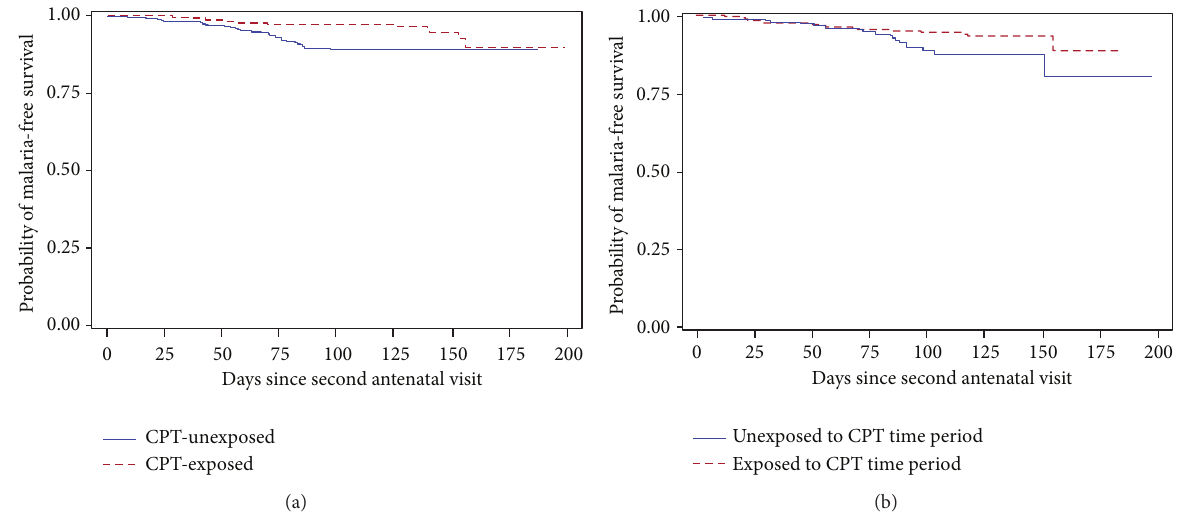
Figure 3: Kaplan-Meier curves illustrating the probability of malaria in HIV-infected pregnant women before and during cotrimoxazole prophylaxis periods for (a) the women with a CD4 less than 500 cells/ 𝜇 L at screening (study population), log rank 𝑃 < 0.0001 , and (b) women who had a CD4 of at least 500 cells/ 𝜇 L at screening (“controls”), log rank 𝑃 = 0.0353 . All women not receiving CPT received